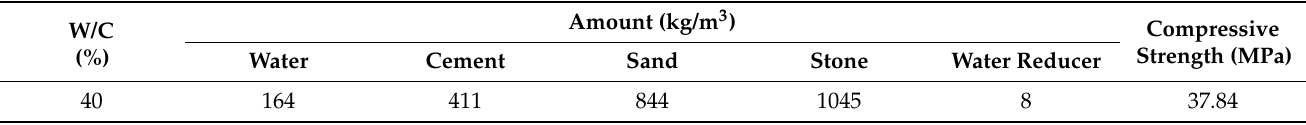
Table 1. Mix proportion of substrate concrete.